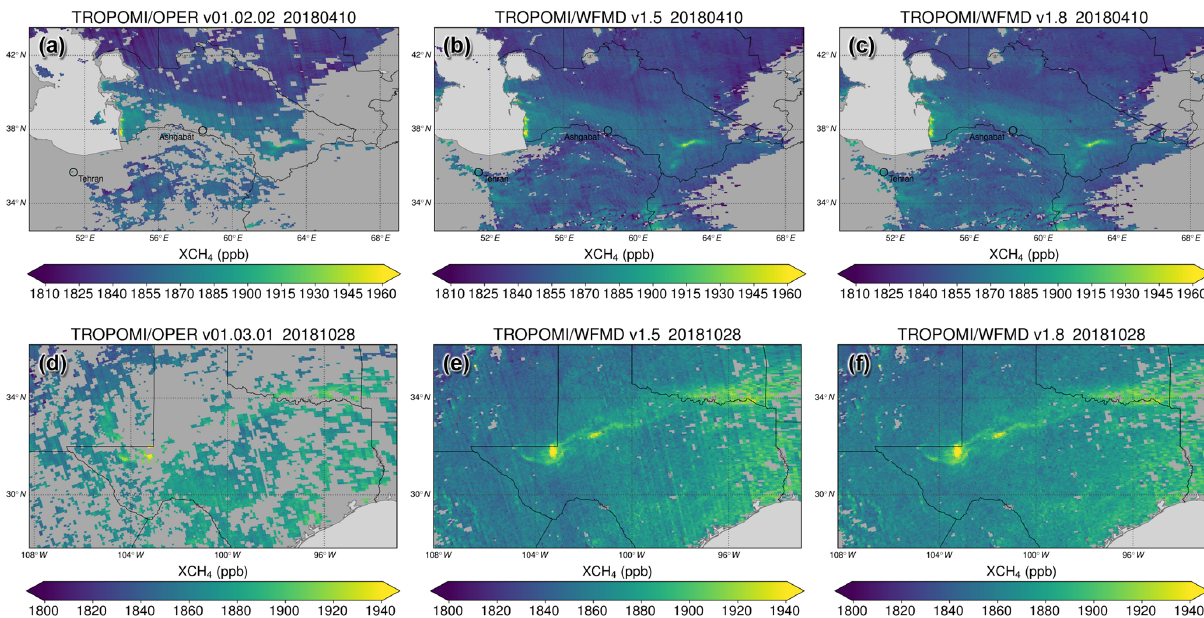
Figure 17. Performance of the destriping filter for the XCH 4 product for two example scenes in (a–c) Turkmenistan and (d–f) the United States with enhancements due to emissions from the oil and gas industry. Panels (b) and (e) show the previous WFMD version, and panels (c) and (f) show the improved version with destriping. The operational product also exhibiting striping is shown in panels (a) and (d) for